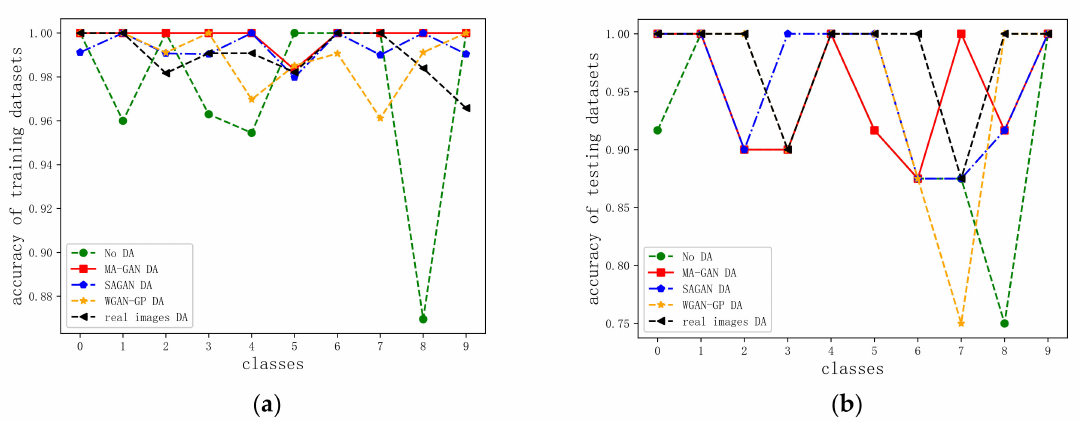
Figure 12. Classified accuracy of the training set and testing set ( a ) before and ( b ) after MNIST augmentation.